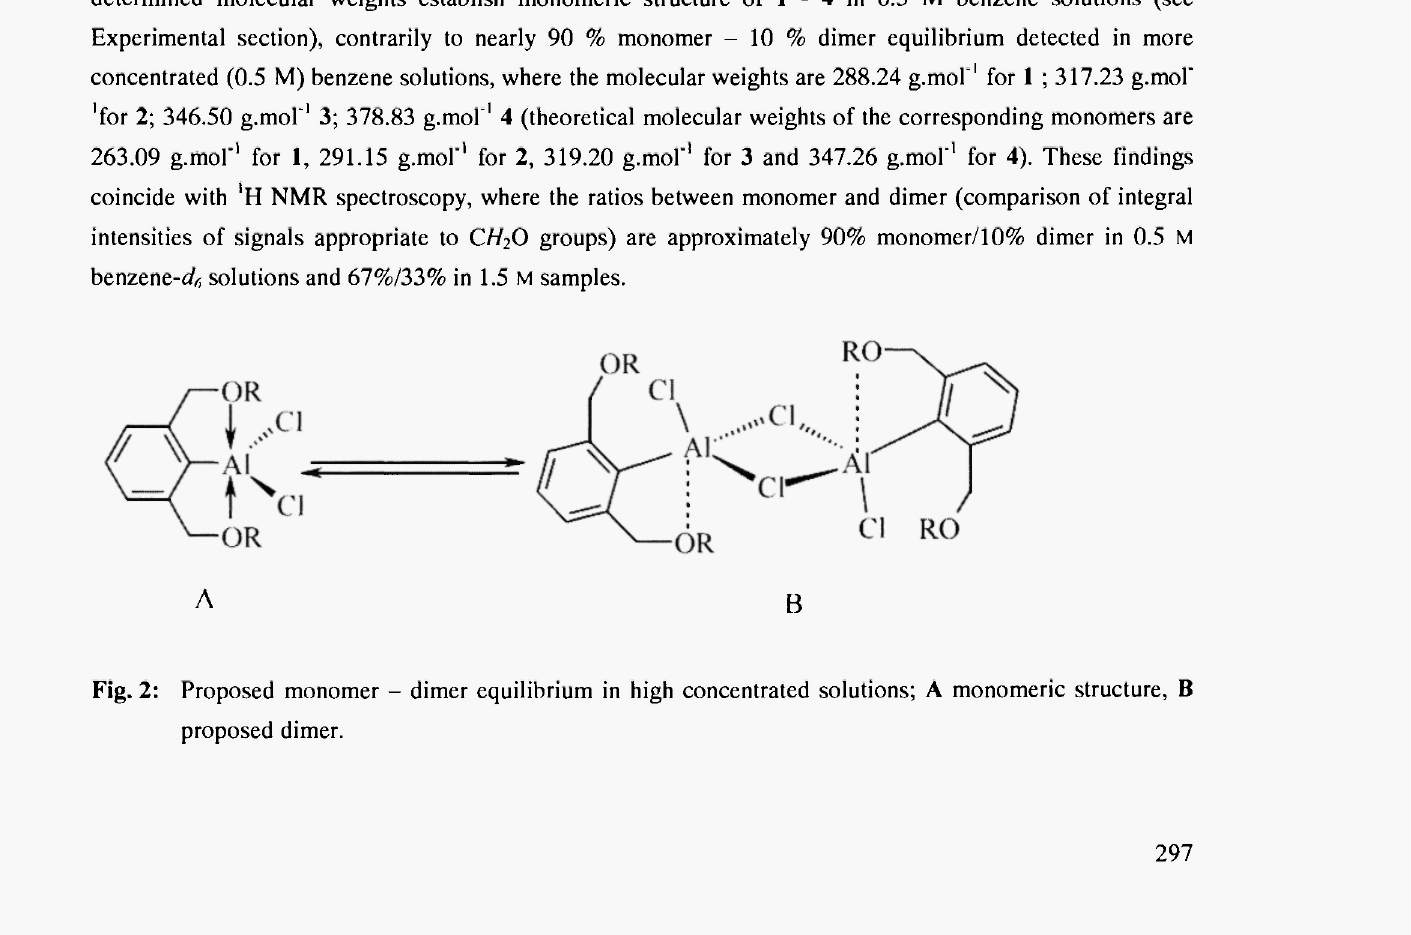
Fig. 1: Aliphatic region of 'H NMR spectra for compound 2 - concentration dependence; 300 K; benzene- d 6 : (a) 1.5 Μ solution of 2; (b) 0.7 Μ solution of 2; (c) 0.3 Μ solution of 2; * overlap of two triplets.